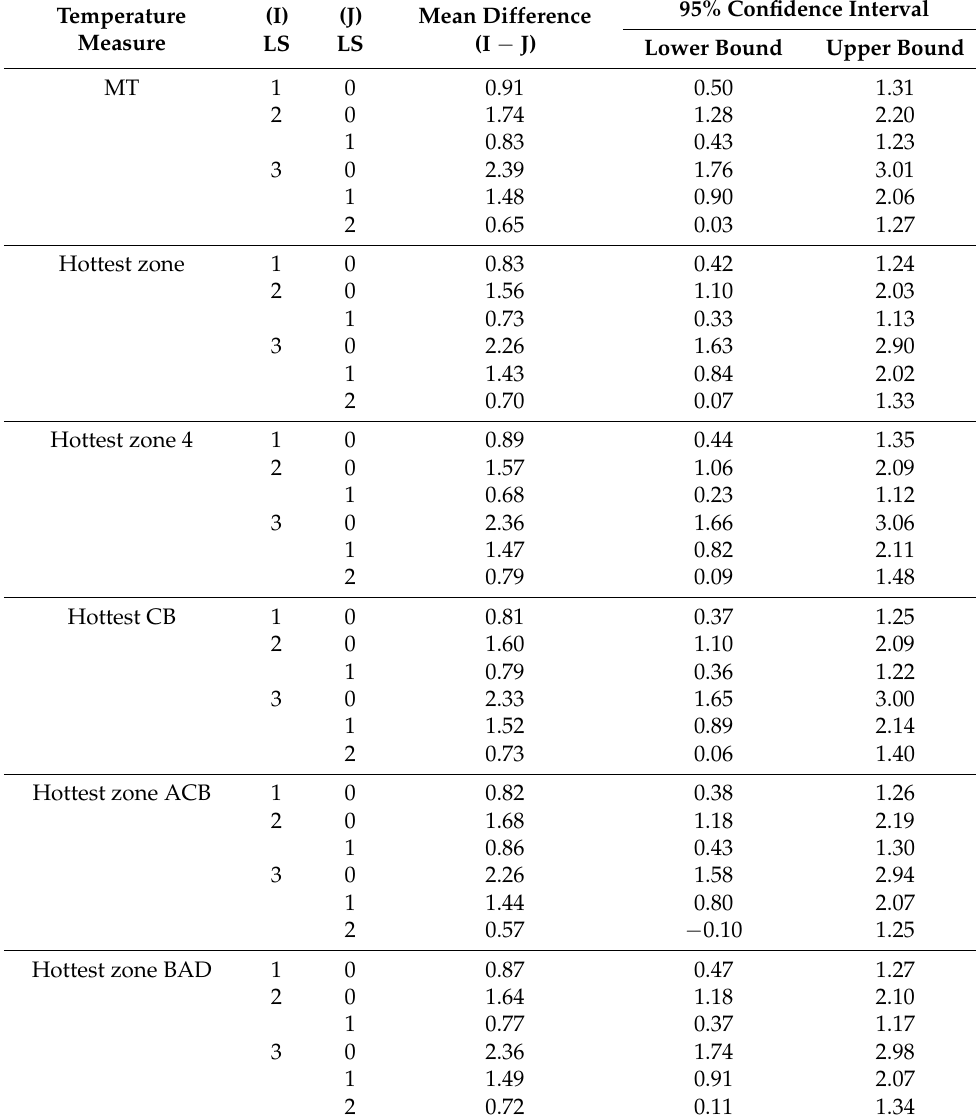
Table 6. Comparisons of mean foot skin temperature for different zones versus locomotion scores (0–3) DairyNZ on three dairy farms in Morogoro ( n =